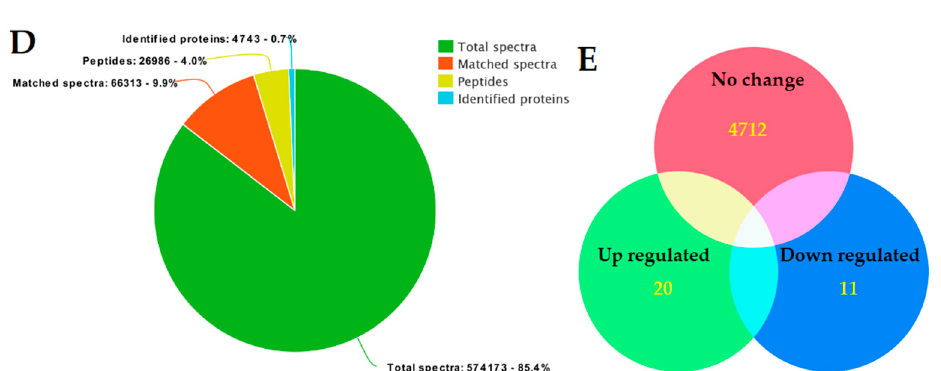
Figure 4. Basic information about the outcome from the proteomic analysis. ( A ) Representation of count data distribution with log2 values in a Box and Whisker plot. ( B ) Histogram showing the frequency of count data distribution of transformed data ( C ) Two-dimensional t-Distributed Stochastic Neighbor Embedding (t-SNE) graph representing the statistical difference between wild type (WT) and mutant line (GXU27-1) ( D ) Information about total spectra, identified matched spectra, peptide, and identified proteins and ( E ) Venn diagram showing the distribution of differentially expressed proteins (DEPs).